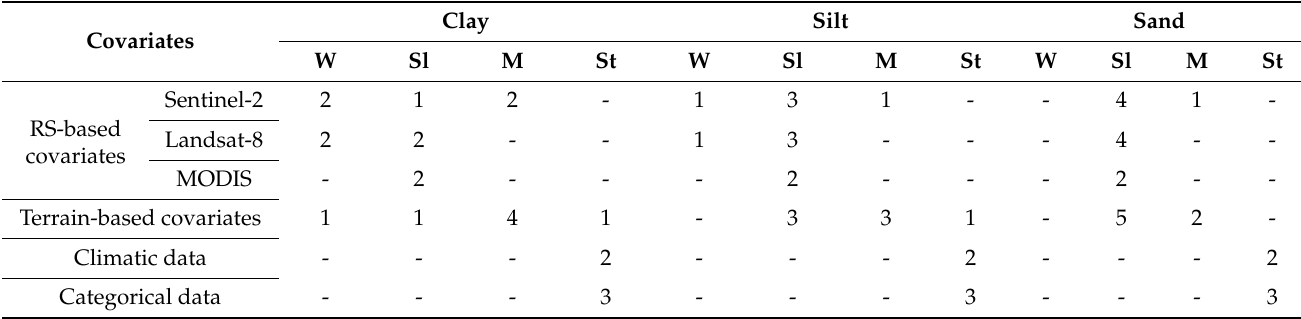
Table 5. The number of covariates with relevance contribution in predicting PSFs. Covariates